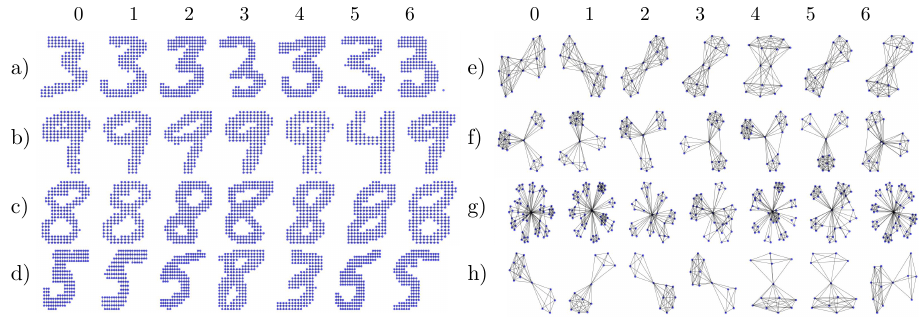
Figure 6. Six nearest neighbors of graphs in the learned latent space for four graphs from IMDB-b and MNIST. Column 0 corresponds to a randomly chosen graph, then the six nearest neighbors are drawn in increasing distance order from left to right (1 to